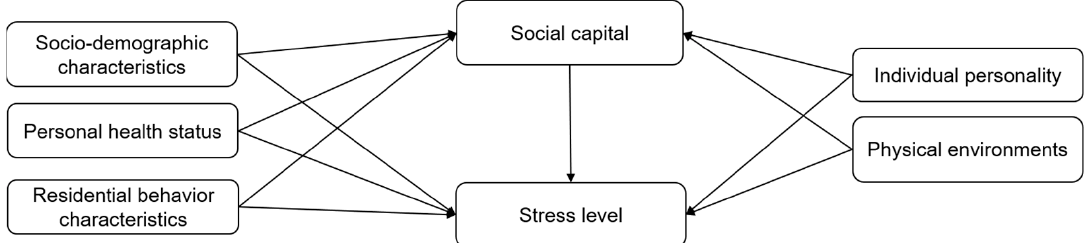
Figure 1. Proposed conceptual framework.